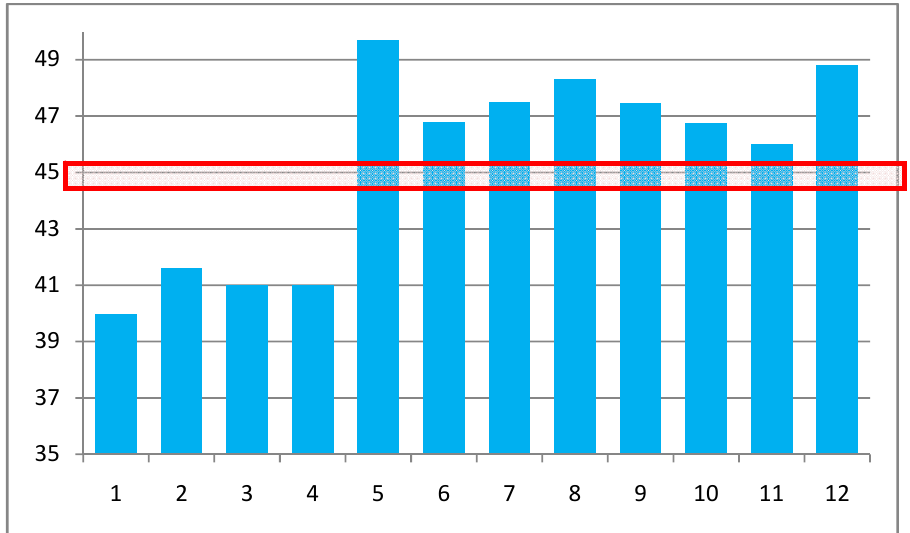
,0,0) computed as indicated in Table 2. The e